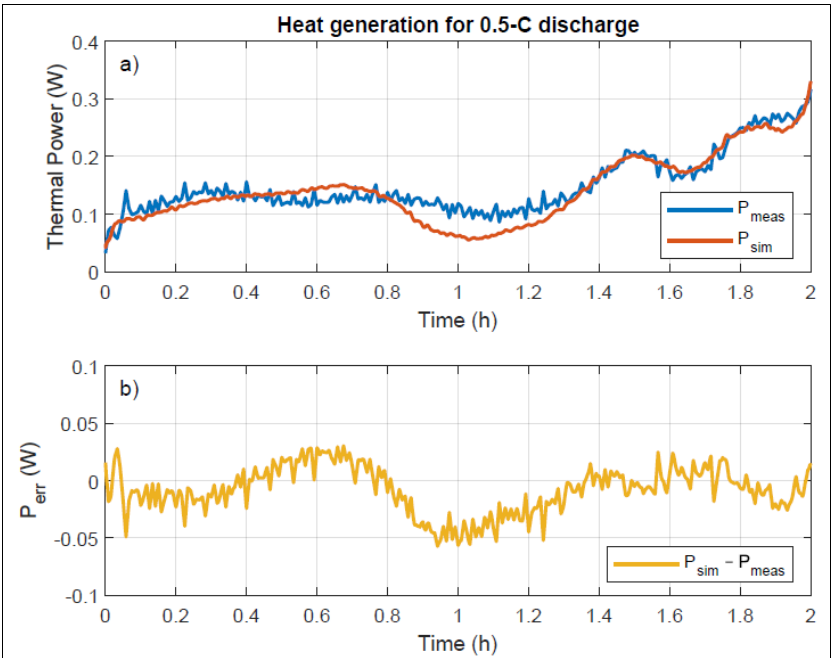
Figure 2. ( a ) Measured and simulated values of thermal power released by a cell at a 0.5-C discharge rate. ( b ) Deviation between estimated thermal power and adiabatic chamber measurements.